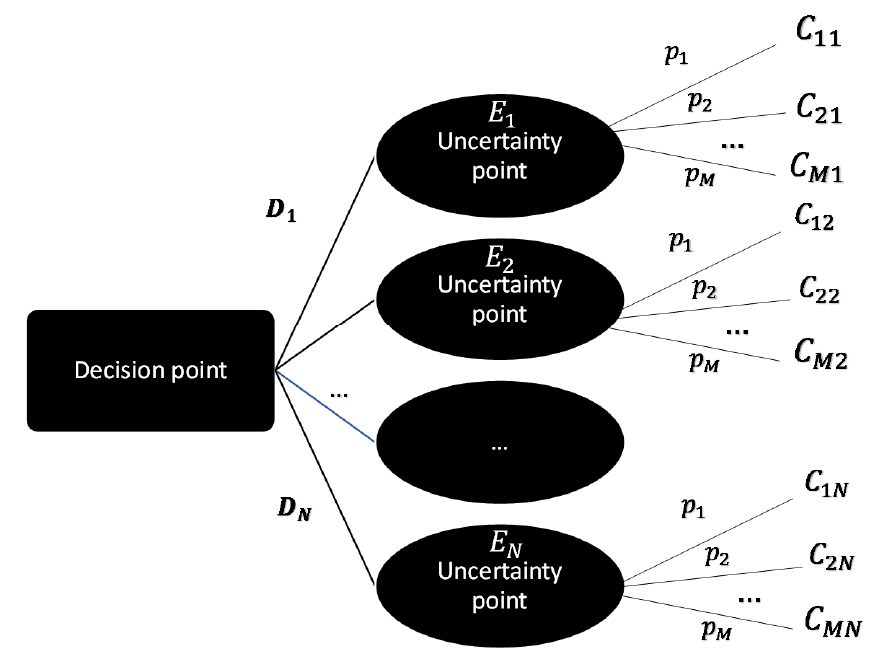
Figure 1. Scenario tree, describing the investment decision making process according to the BIF, consisting of M scenarios (each with a probability p i ) and N candidate investment decisions ( D 1 , . . . D N ), one of which will be selected as the optimal.